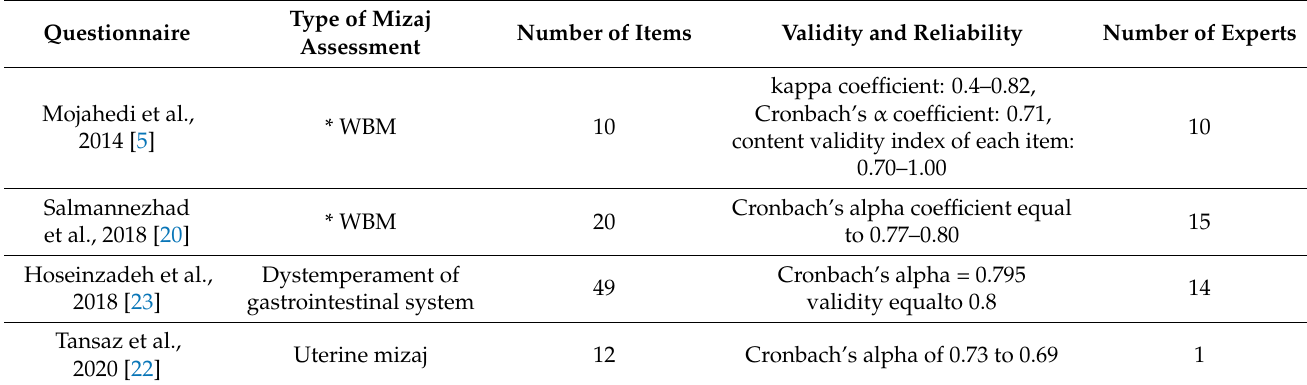
Table 2. Details of articles with questionnaires.